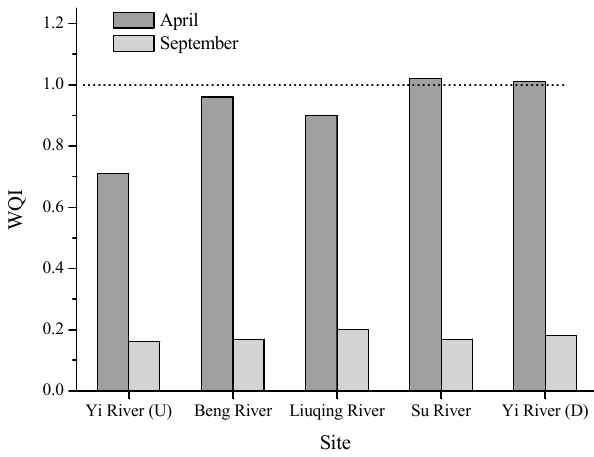
Figure 2. Water quality index (WQI) of heavy metals in the water samples in April and September, 2017.